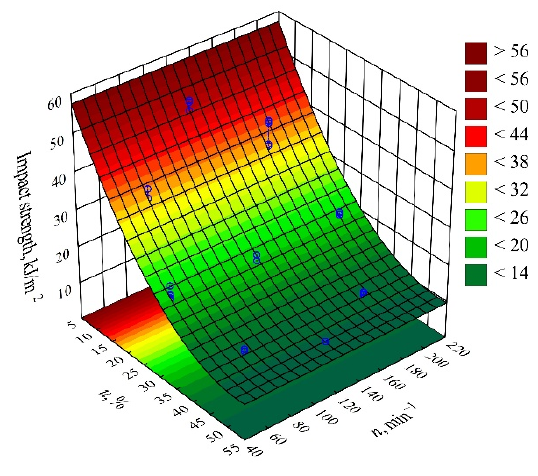
Figure 19. Response surface plot for the impact strength versus wheat bran content u and screw speed n. speed n